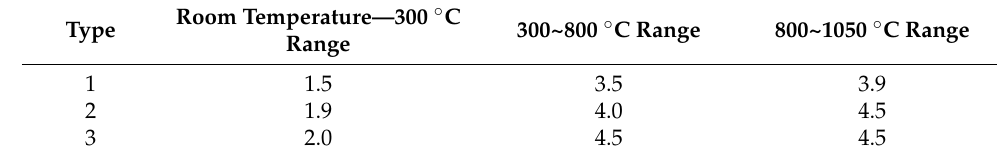
Table 10. Type of heating rate ( °C /min).